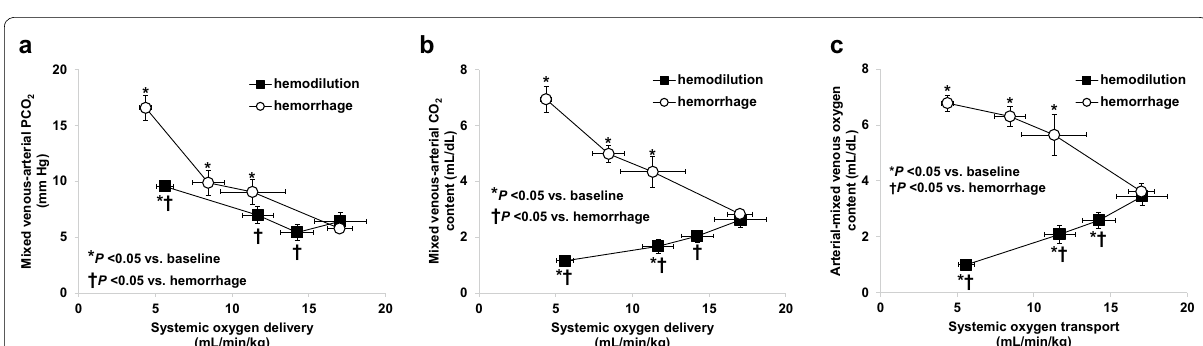
Fig. 3 Relationship between oxygen transport to venoarterial PCO 2 difference (P v–a CO 2 ) ( a ), venoarterial CO 2 content difference (C v–a CO 2 ) ( b ), and arteriovenous O 2 content difference (C a–v O 2 ) ( c ). Hemodilution produced opposite effects on P v–a CO 2 and C v–a CO 2 . C v–a CO 2 decreased in hemodilu- tion and increased in hemorrhage. These changes are the underlying explanation for different behavior of P v–a CO 2 /C a–v O 2 in both